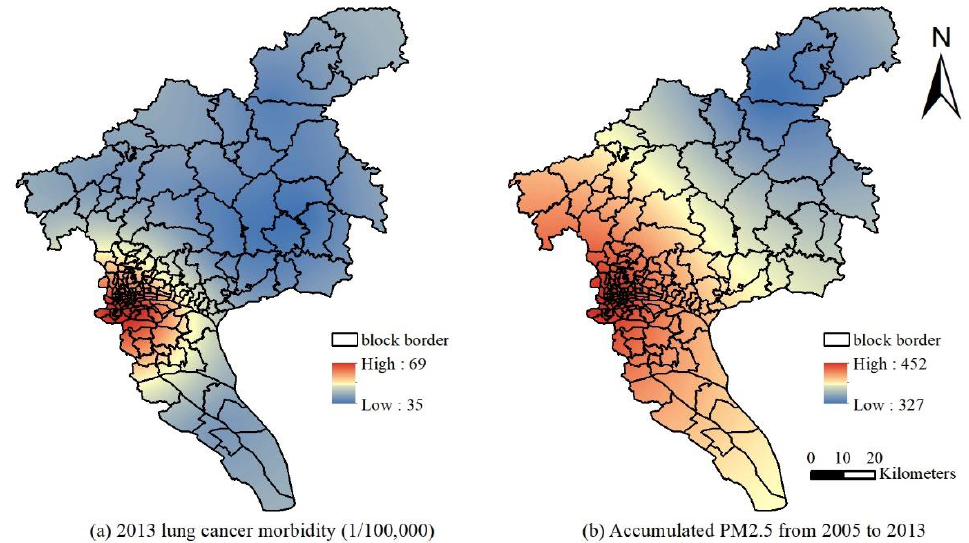
Figure 10. Spatial distribution of lung cancer incidence in 2015 and the total concentration of PM 2.5